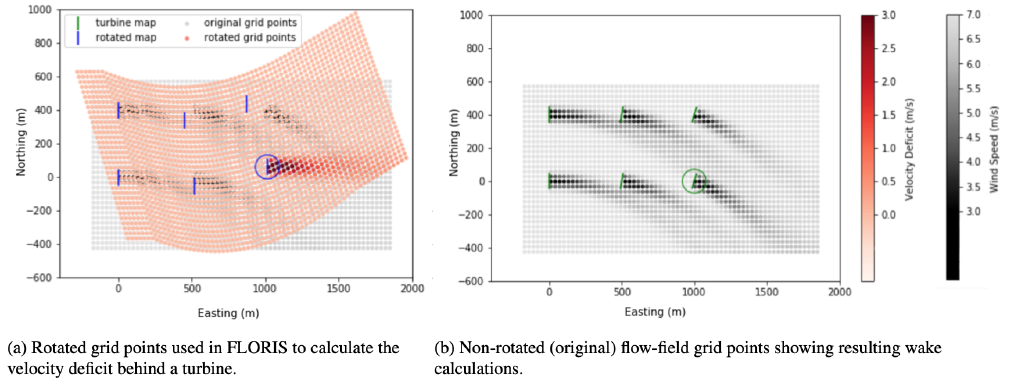
Figure 7. Visualizations of FLORIS calculating velocity deficit turbine T6 in conditions of heterogeneous wind direction. The velocity deficit is calculated using the grid points in the fully rotated position (a) and then applied to the free-stream velocity defined at the grid points in their original non-rotated location (b) .